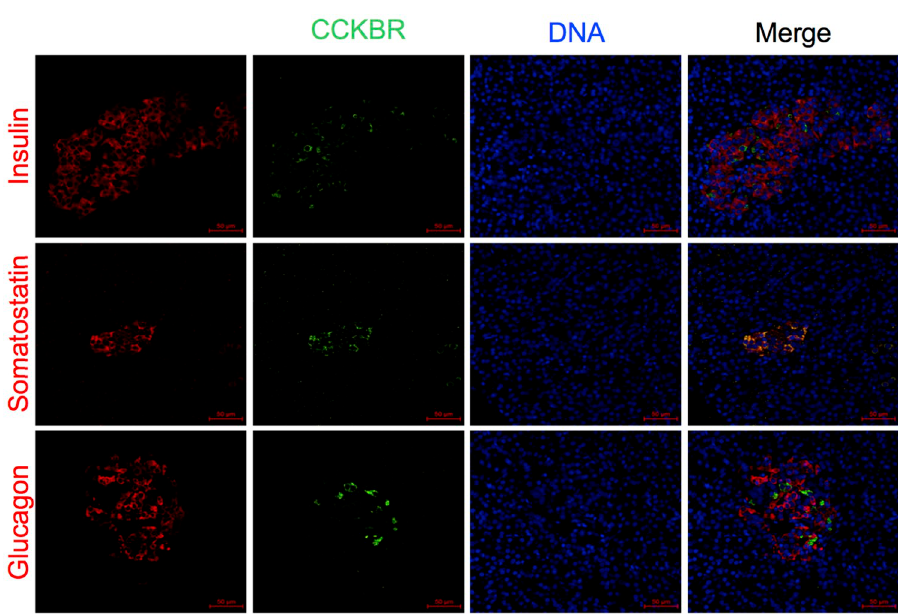
Fig 4. CCKBR is expressed in delta cells of islets from donors with HbA 1c < 42 mmol/mol. Formalin-fixed, paraffin-embedded tissue sections of adult human pancreases were examined by double immunofluorescence staining for gastrin receptor CCKBR (green) together with a major islet hormone; insulin, glucagon or somatostatin (red). DNA was stained blue with DAPI. Data from a total of 5–7 and 5–8 independent donors of lower and higher HbA 1c ,